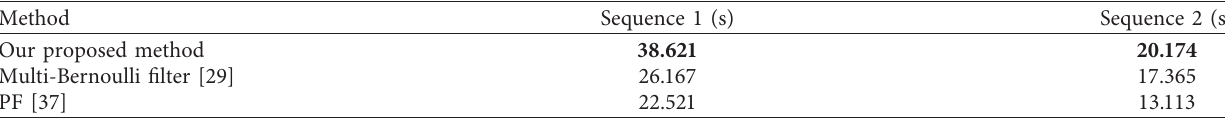
Table 6: Comparison speed using various methods.